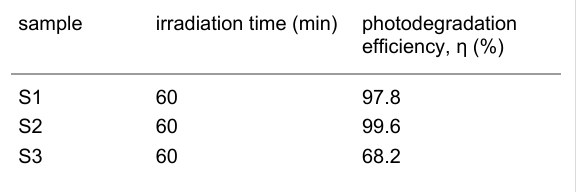
Table 1: Photodegradation efficiency of different photocatalysts